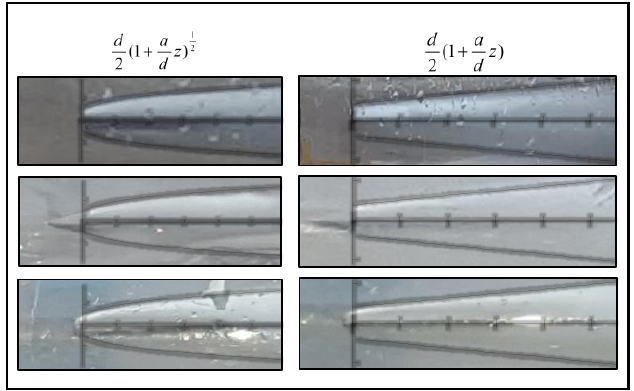
Figure 6. The geometries of the supercavitation bubble for three different cavitators. Table 1. Flow velocity at the front edge of the cavitator in Stages 1 – 6 of the bubble development for the three cavitators.